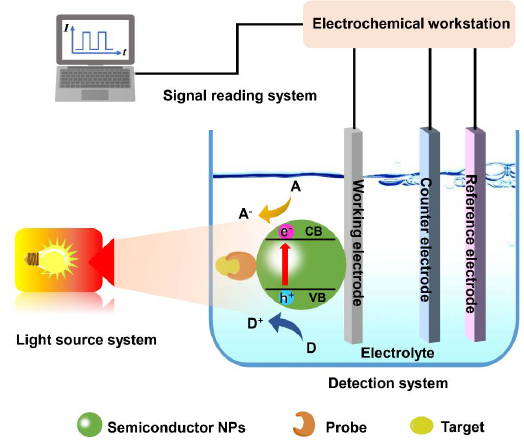
Figure 1. Diagram of typical PEC biosensing system.